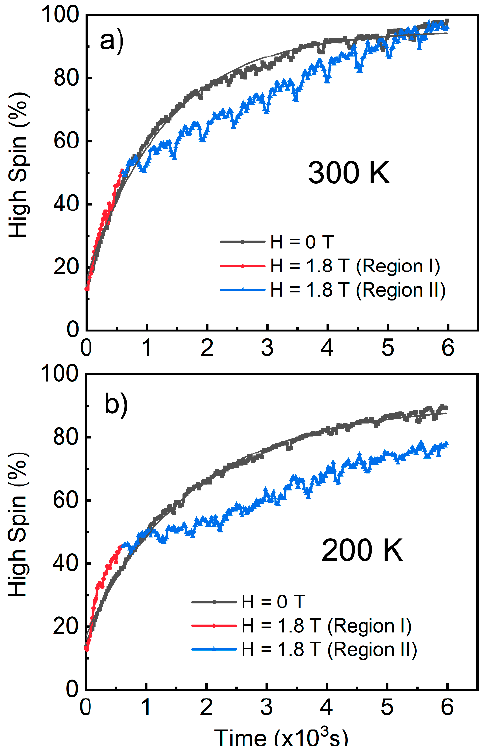
Figure 2. The evolution of the high-spin state occupancy in the [Fe{H 2 B(pz) 2 } 2 (bipy)] thin films, on NiCo 2 O 4 (111), that accompany an incident soft X-ray fluence are plotted for ( a ) 300 K and ( b ) 200 K, in the absence of an applied magnetic field (black) as well as in the presence of a 1.8 T applied magnetic field (red and blue). Exponential fits to the high-spin state conversion in the absence of an applied magnetic field are indicated.